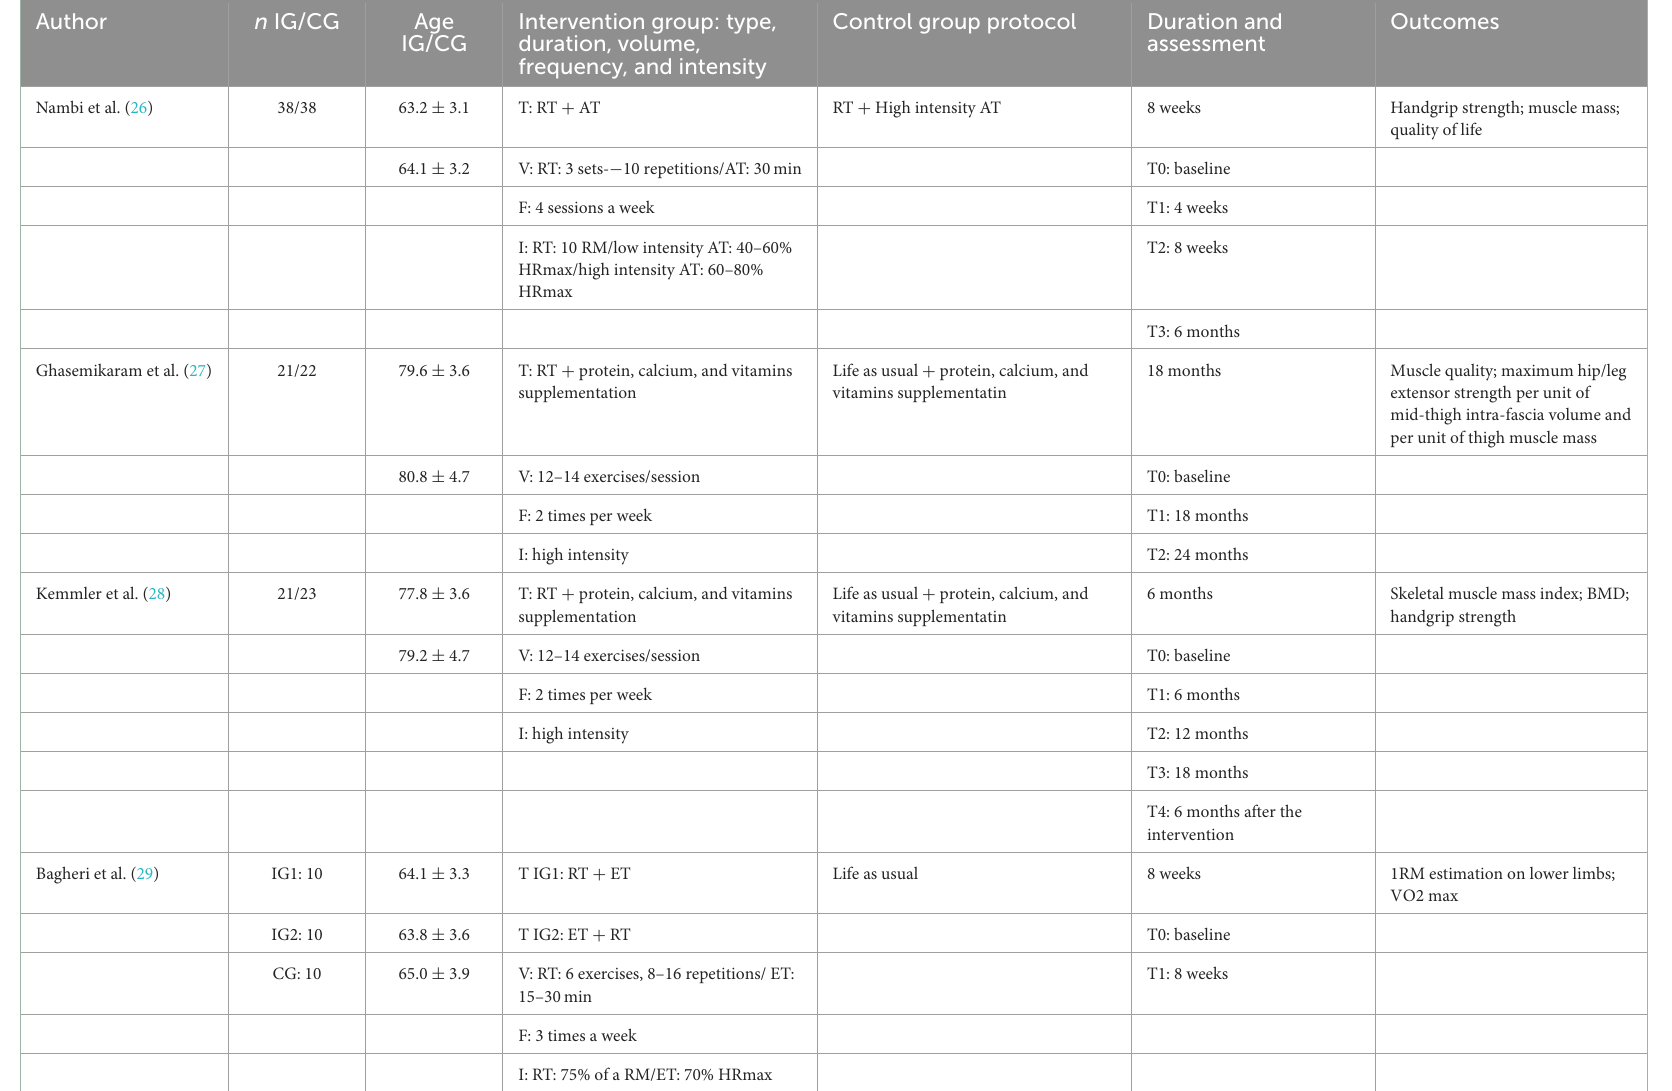
TABLE 2 Characteristics of the